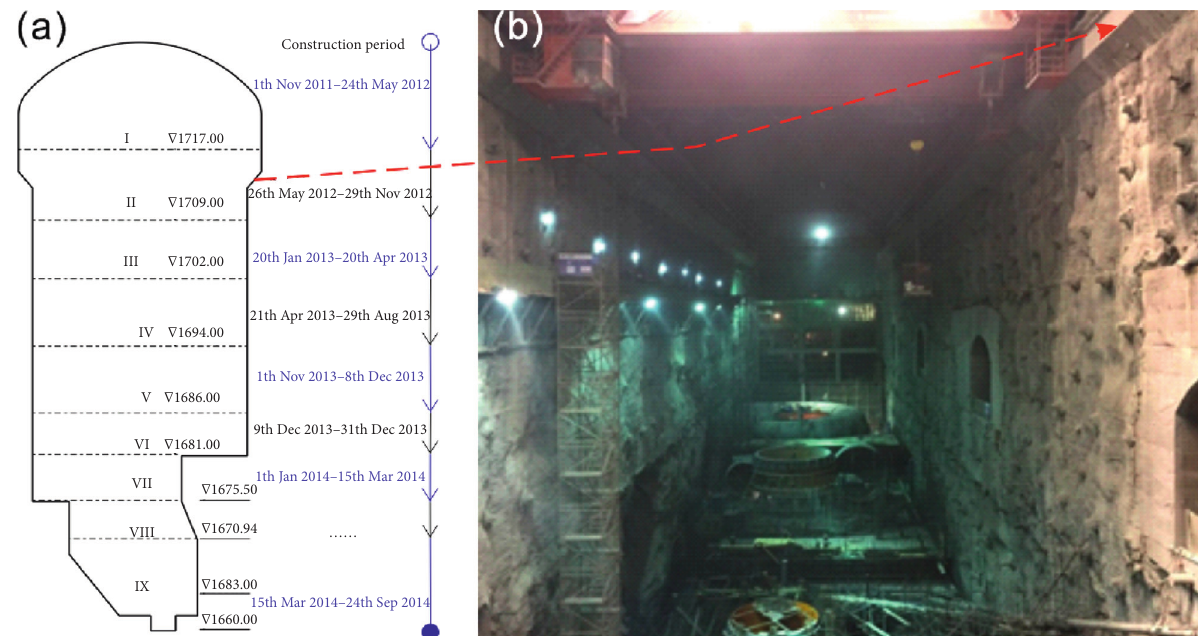
Figure 3: Specific stratified excavation scheme of the main powerhouse.